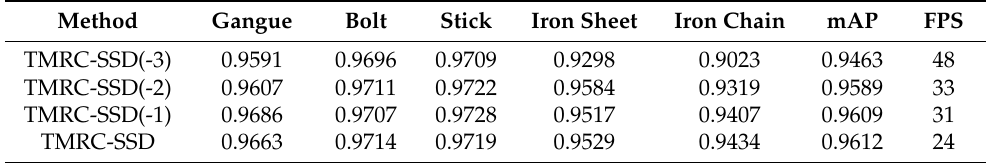
Table 7. Performance with different components for five type of